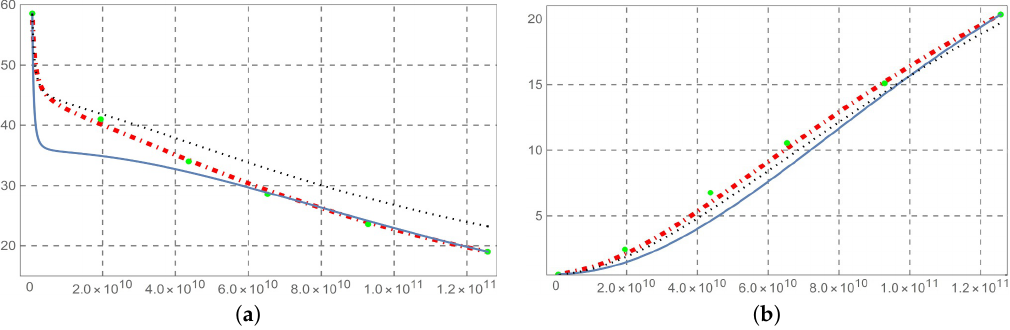
Figure 8. ( a ) Permittivity and ( b ) conductivity 100 MHz @ 20 GHz. Line dot-dashed fractional model α = 0.983, line continue ordinary model, line dotted extensive Cole–Cole’s model, points experimental data.